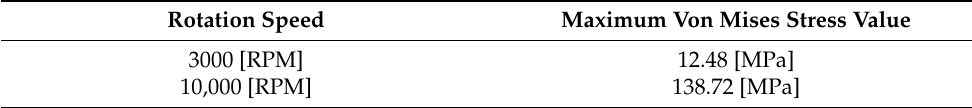
Table 6. Mechanical stress analysis result of the optimum